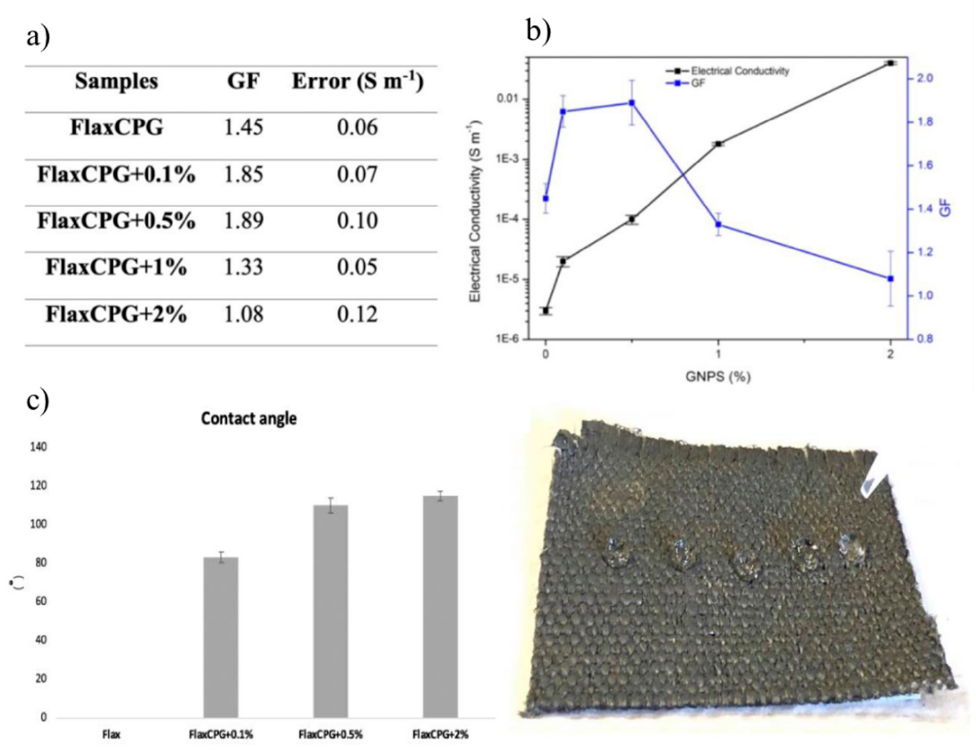
Figure 8. Average GF values ( a ) and relation between electrical conductivity and GF ( b ). WCA values obtained for the flax sample and the flax samples functionalized with the polymeric formulation with different concentrations of GNPs ( c ) [111].